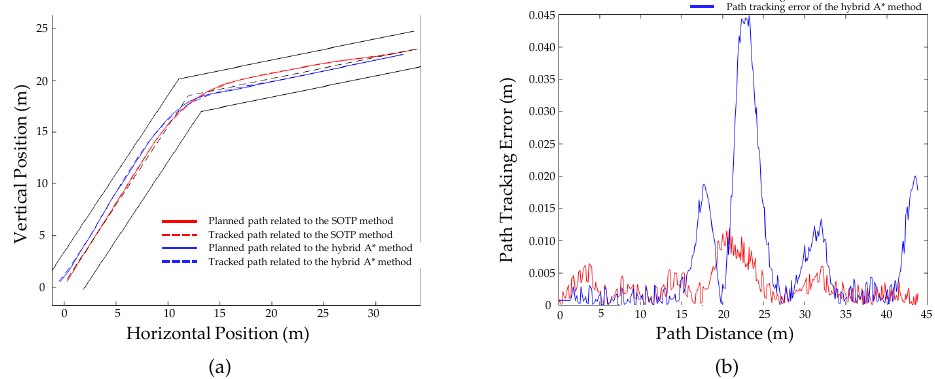
Figure 13. The trajectories tracking results in the field experiment. ( a ) the path tracking performance ( b ) the path tracking